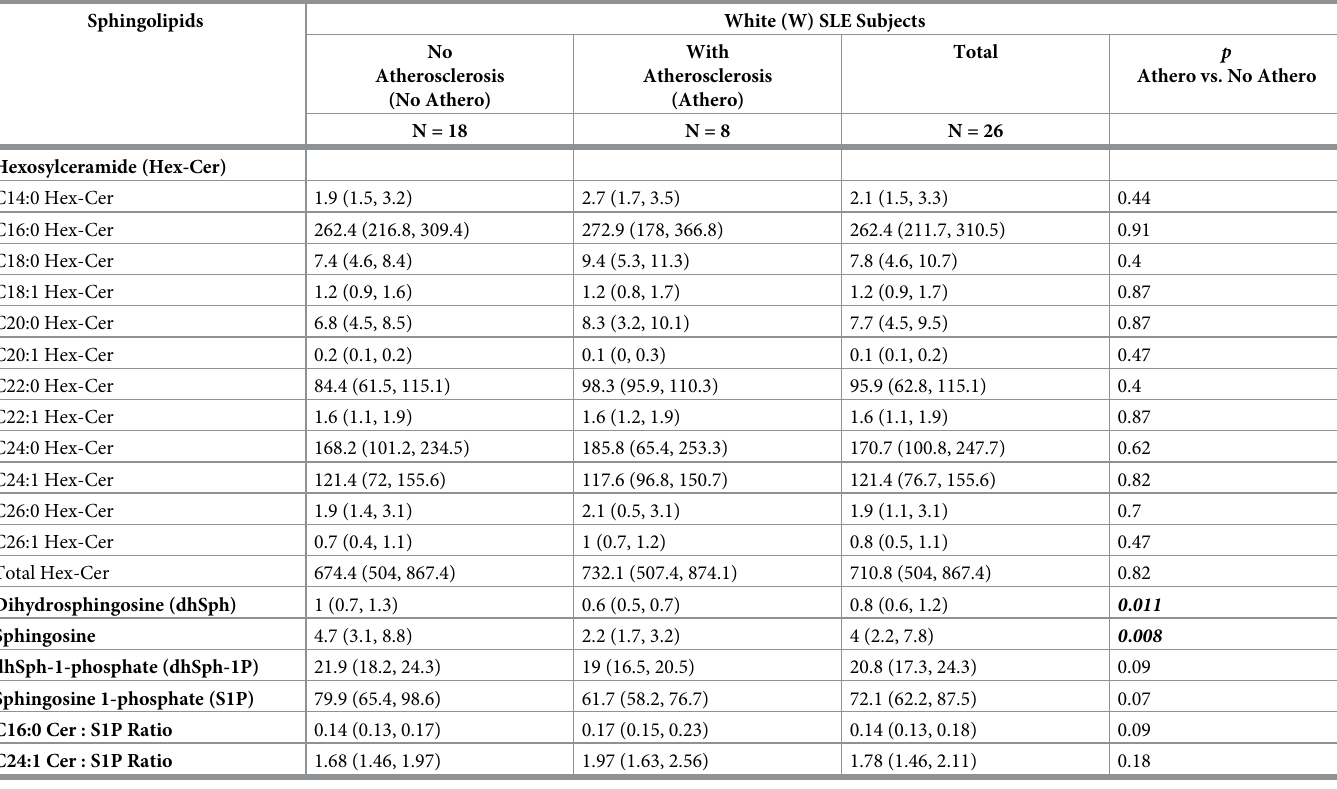
without atherosclerosis (Table 4), although these differences did not remain significant after controlling for multiple comparisons.